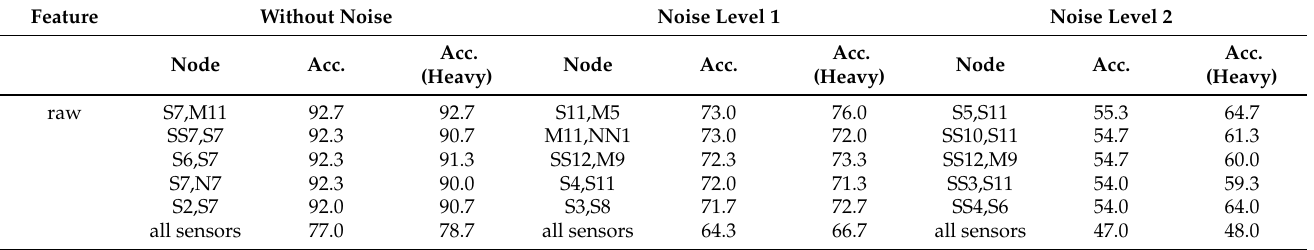
Table 4. Results for the five sensor pairs of each feature with the highest accuracy (Acc.) calculated based on displacement in the z direction. The bottom six rows show the result for using all features. In the first column, the results for a Without Noise signal are given. The standard deviation of the noise σ N and the corresponding SNR for the noise levels can be taken from Table